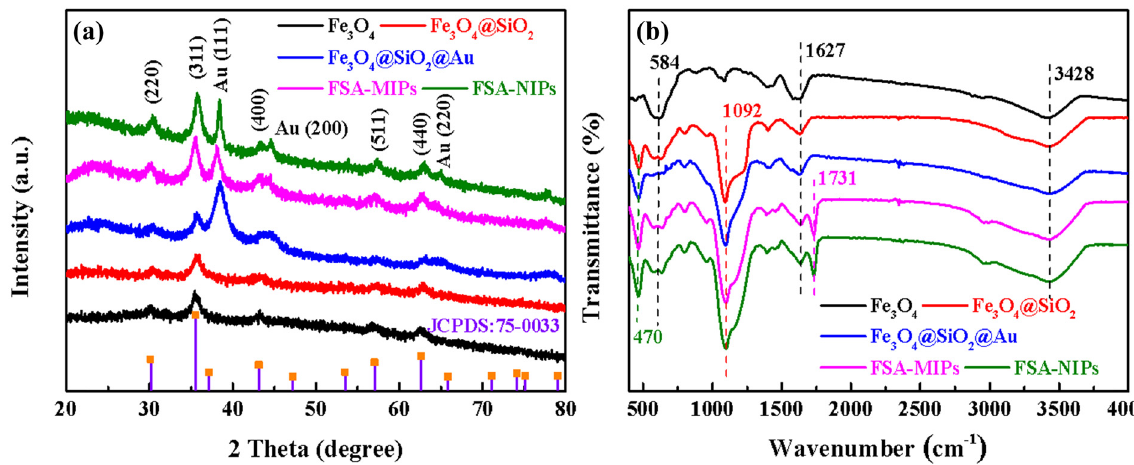
Figure 1: ( a ) X - ray di ff raction patterns and ( b ) FTIR spectra of Fe 3 O 4 , Fe 3 O 4 @SiO 2 , Fe 3 O 4 @SiO 2 @Au, FSA - MIPs, and FSA